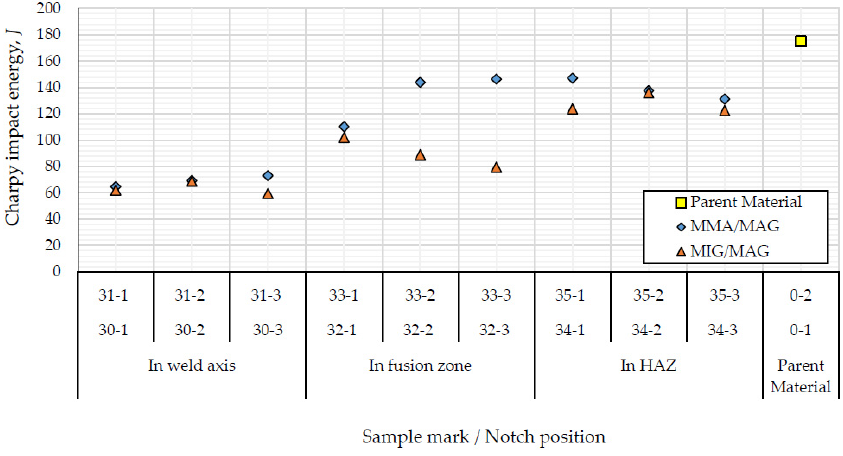
Figure 8. Appl. Sci. 2020 , 10 , x FOR PEER REVIEW